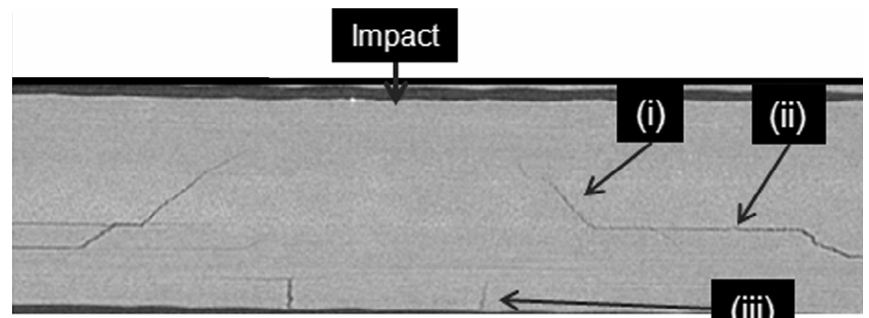
Figure 1. Computer tomography of impact damage in CRFP (Bull et al.,